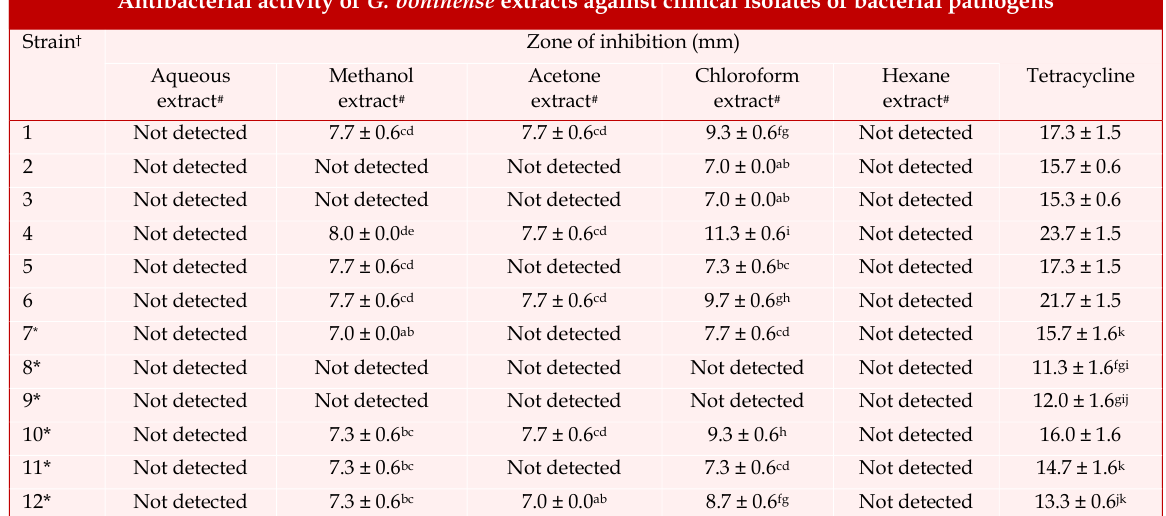
Antibacterial activity of G. boninense extracts against clinical isolates of bacterial pathogens Strain